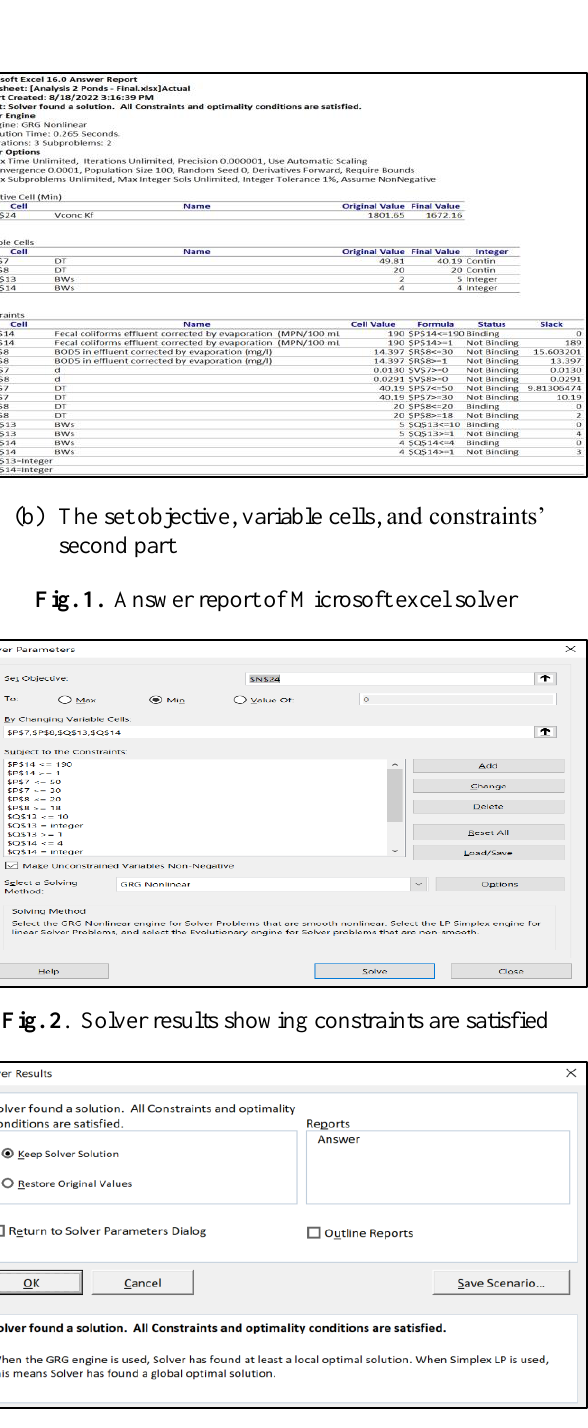
Fig. 3. Excel solver answer report